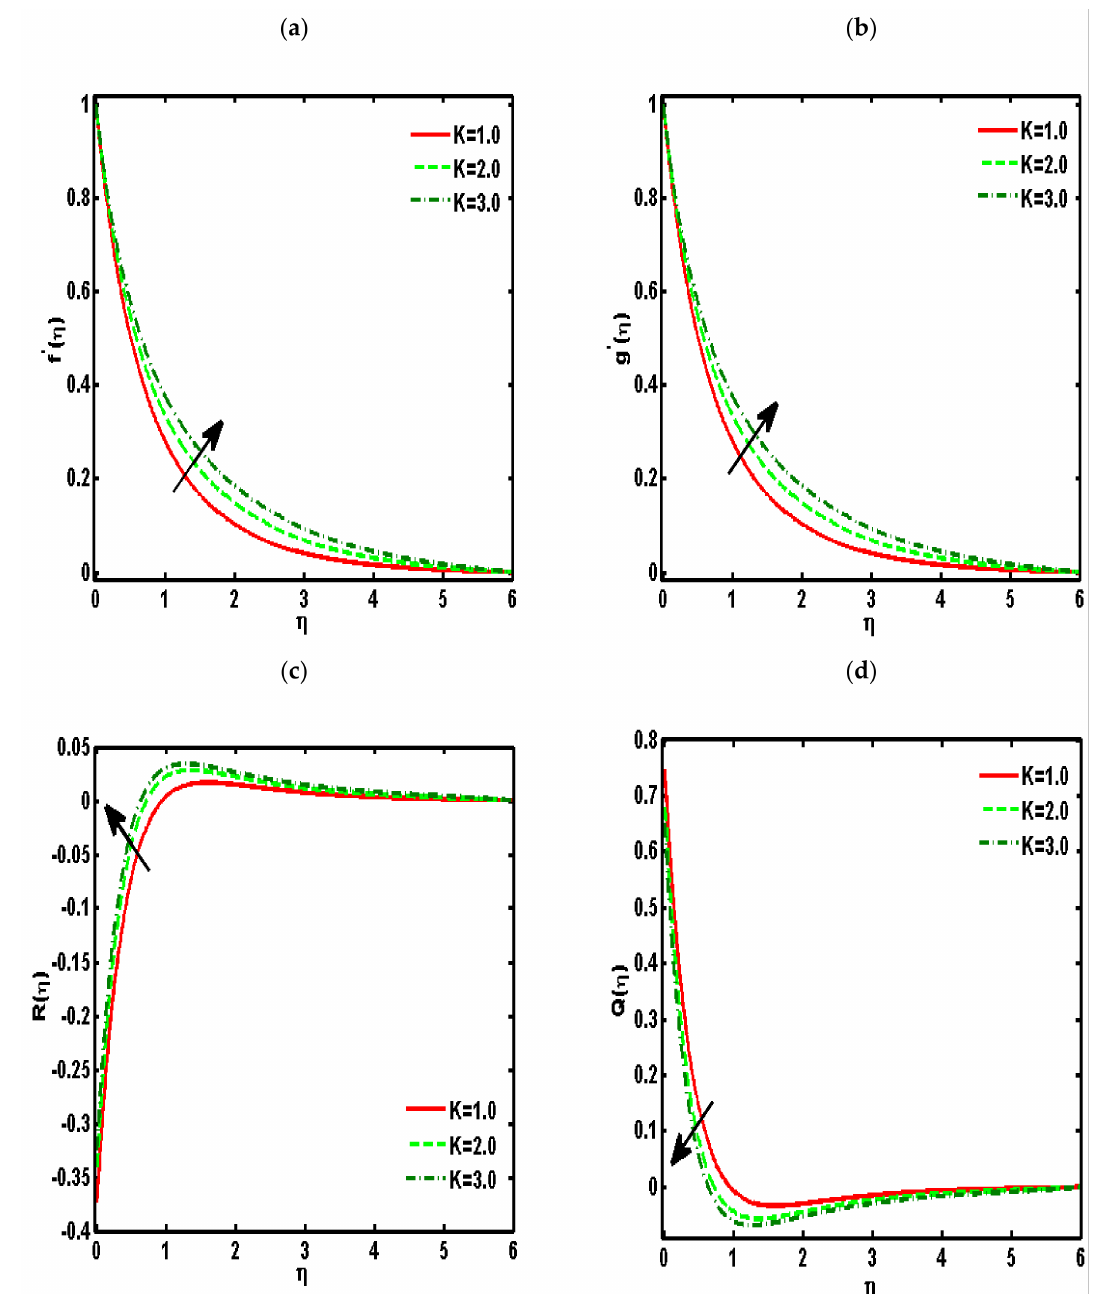
Figure 3. Effects of the dimensionless viscosity ratio ( K ) on ( a ) f (cid:48) ( η ) , ( b ) g (cid:48) ( η ) , ( c ) R ( η ) , ( d ) Q ( η ) . ( φ 2 = 0.01, Pr = 6.2, a = 0.5, c =